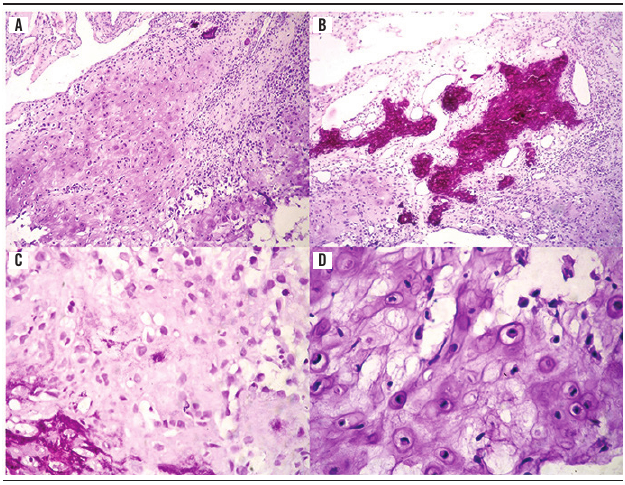
FigurE 3 − Histological sections stained with HE A) deposition of basophilic and eosinophilic material consistent with chondroid and osteoid matrix, respectively; B) intense deposition of interspersed mineralized trabecular tissue through a hypercellularized connective tissue; C) osteoid matrix and presence of atypical osteoblasts with ovoid to fusiform morphology; D) irregular gaps within the chondroid matrix (chondroplasts) containing cells predominantly compatible with atypical chondroblasts. HE: hematoxylin and eosin.